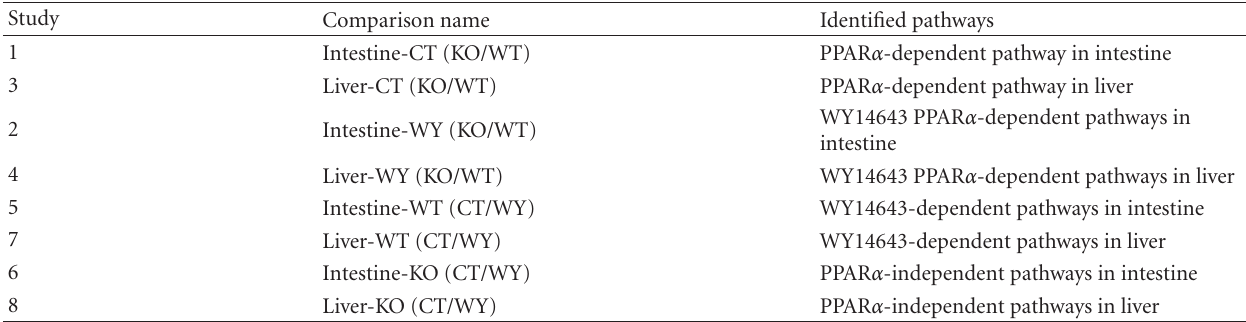
Table 2: Summary of 8 comparison